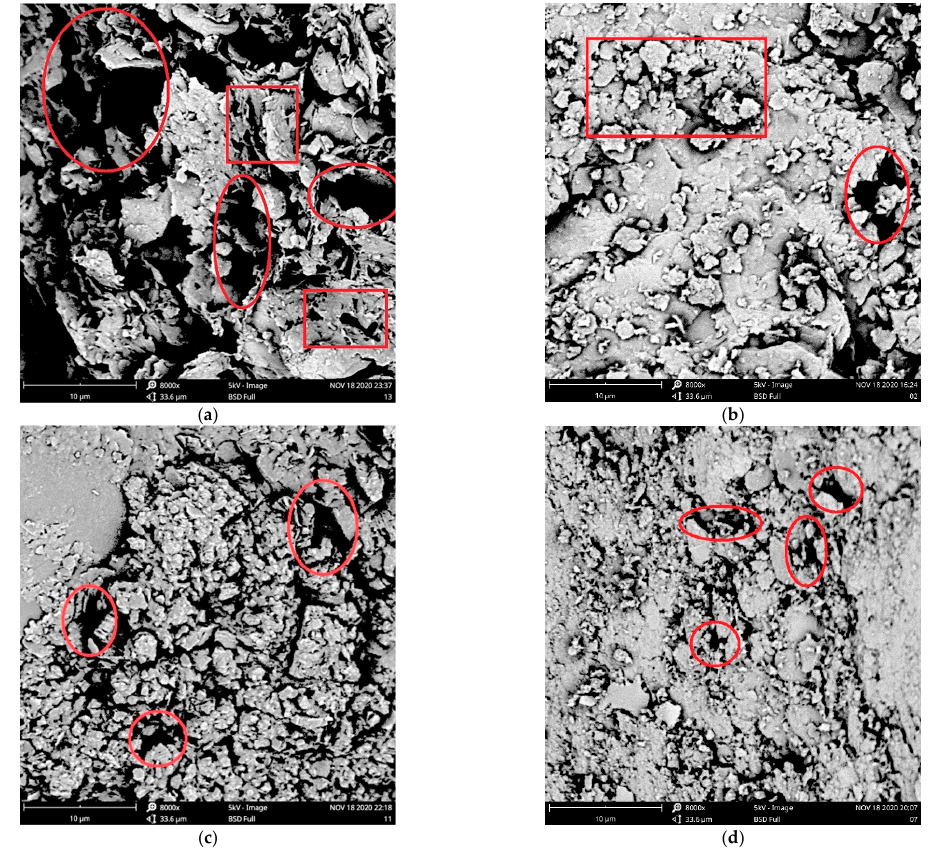
Figure 6. Microscan images ( a ) before and ( b ) after typical loading; honeycomb structure ( c ) before and ( d ) after loading. Note: circles indicate pores, and rectangles indicate flocculent structures.